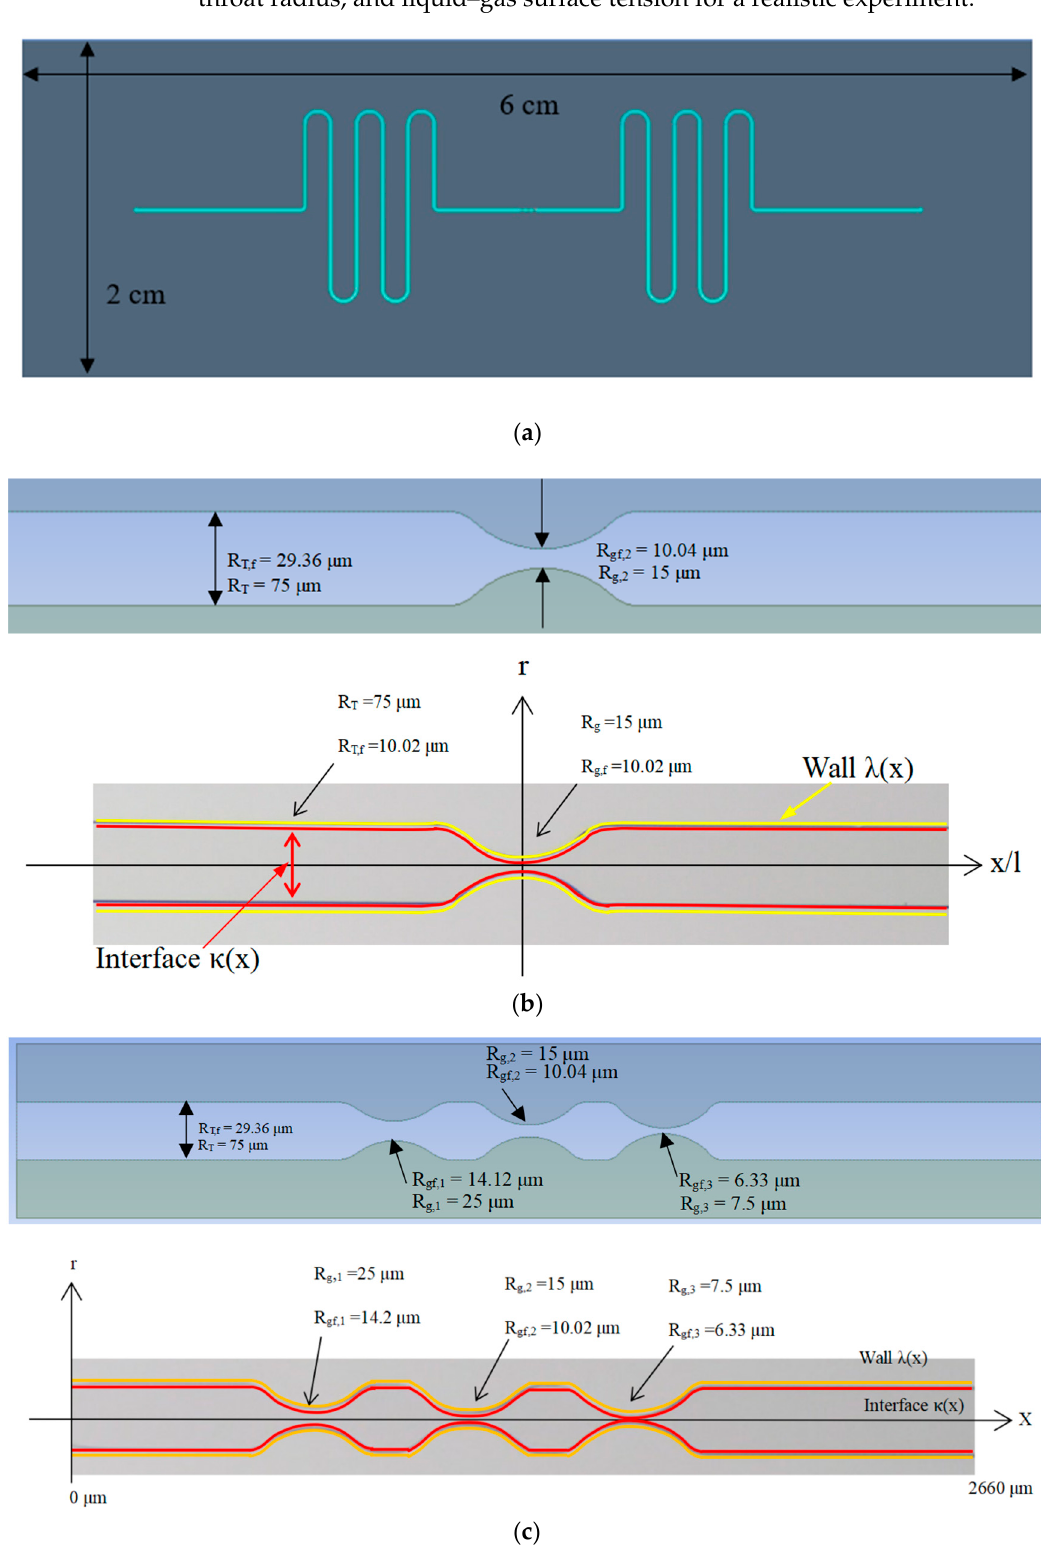
Figure 2. Model Specifications Illustration: ( a ) Experiment Glass Chip Structure, ( b ) Axisymmetric Pore Throat, ( c ) Continuously Tapering Pore Throat .